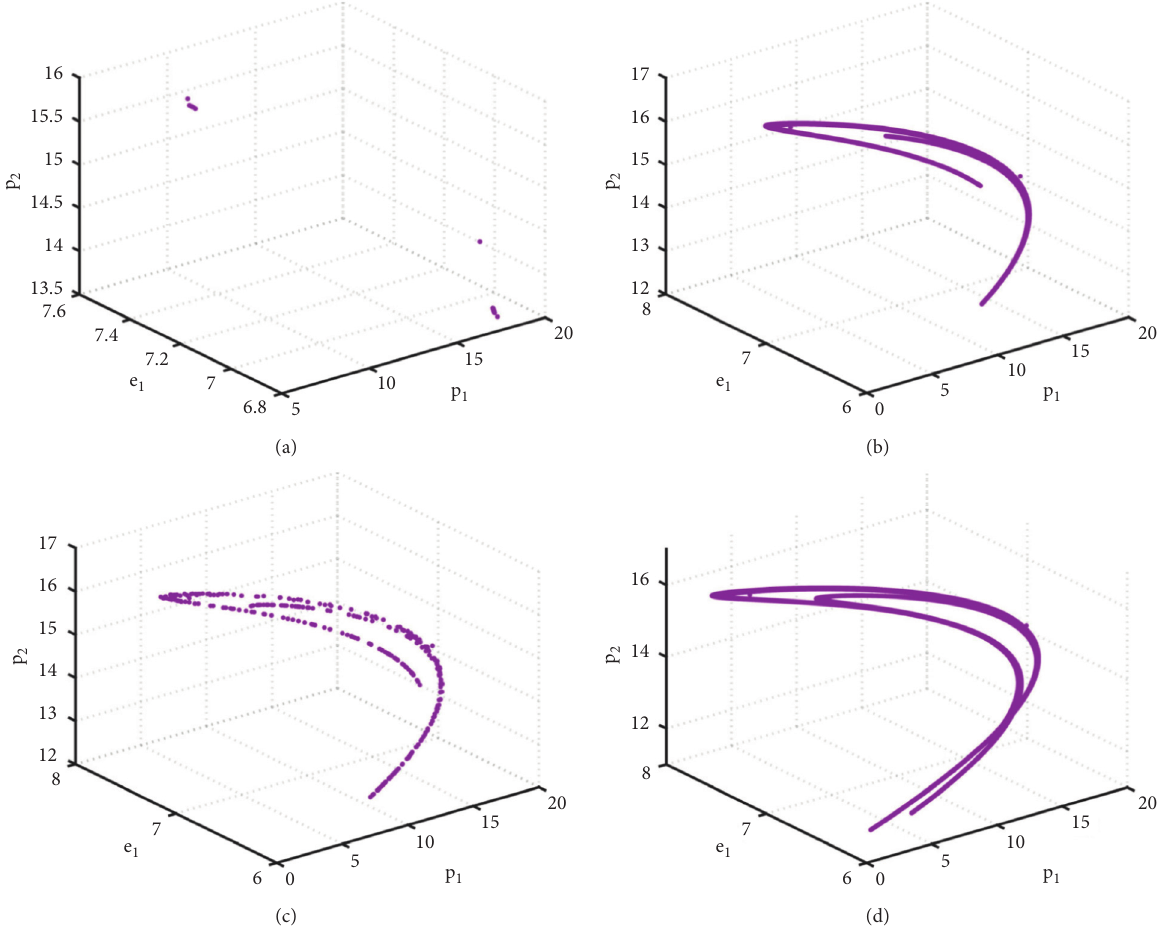
Figure 11: nl singular attractors with u